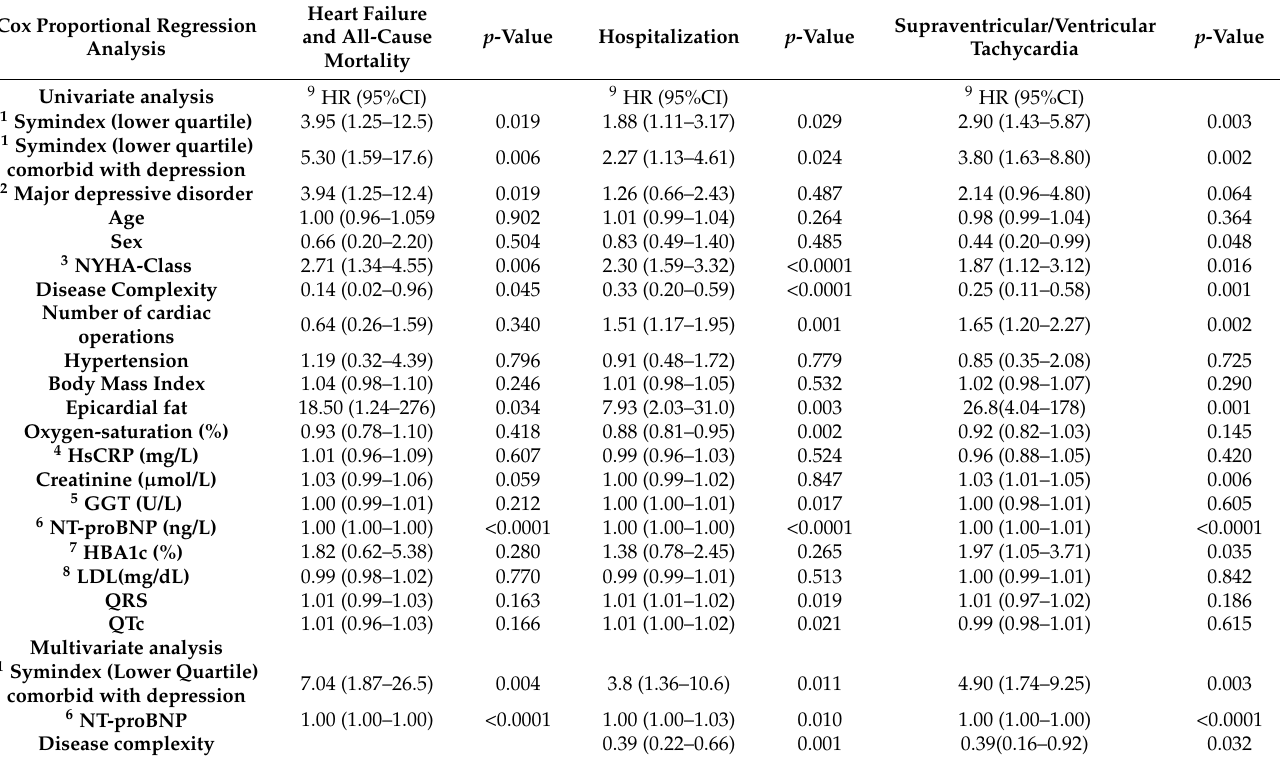
Table 4. Cox proportional survival analysis stratified according to combined parameter reduced heart rate variability (lower quartile of the Symindex) and depression. The data of univariate and multivariate Cox proportional Regression Analysis are presented separately for all three endpoints—heart failure and death, hospitalization and arrhythmias. The parameter Symindex comorbid with depression included depressive patients within the lower quartile of the Symindex. Even after adjustment for age, sex, and β -Blocker therapy, reduced heart rate variability remained as an independent predictor. In multivariate proportional survival analysis, the combined parameter of the lower quartile of the Symindex comorbid with depression remained as an independent predictor, whereas neither the lower quartile of the Symindex alone nor depression yielded significant